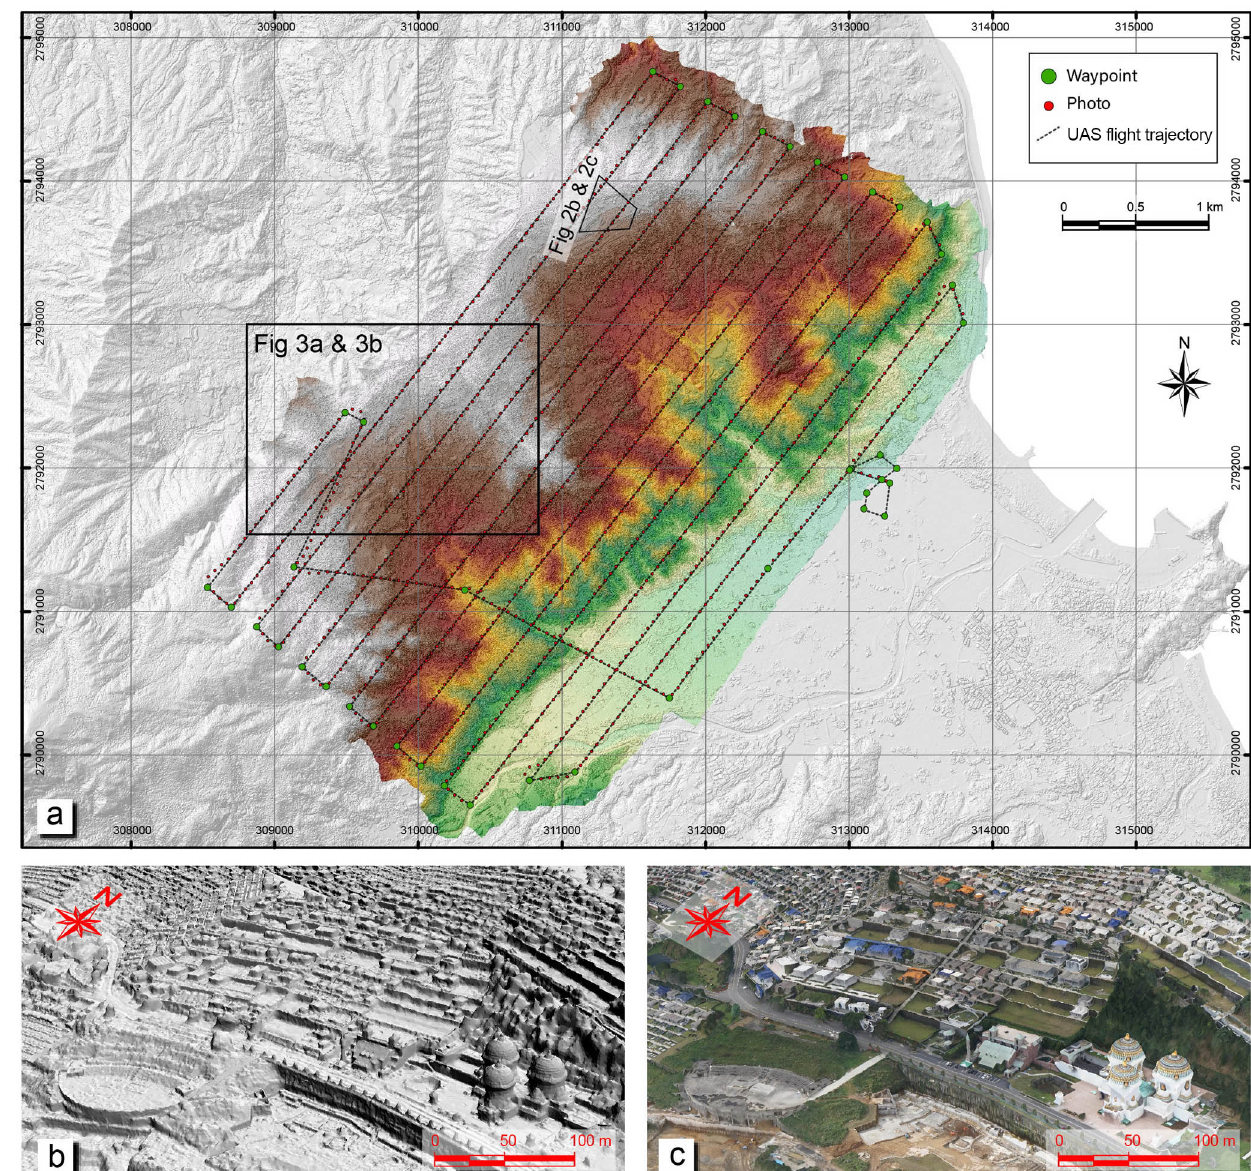
Figure 2. Data acquisition from an unmanned aircraft system flight mission. (a) DSM generated by the UAS for a total area of 14.7km 2 with a ground sampling distance of 6.6cm, where points and lines represent the positions and path of the flight mission, respectively, and the monotone gray area is the lidar DSM; (b) side view of the hillshaded true 3-D model; and (c) image draped onto the true 3-D model. The side views of (b) and (c) are captured at the same position and